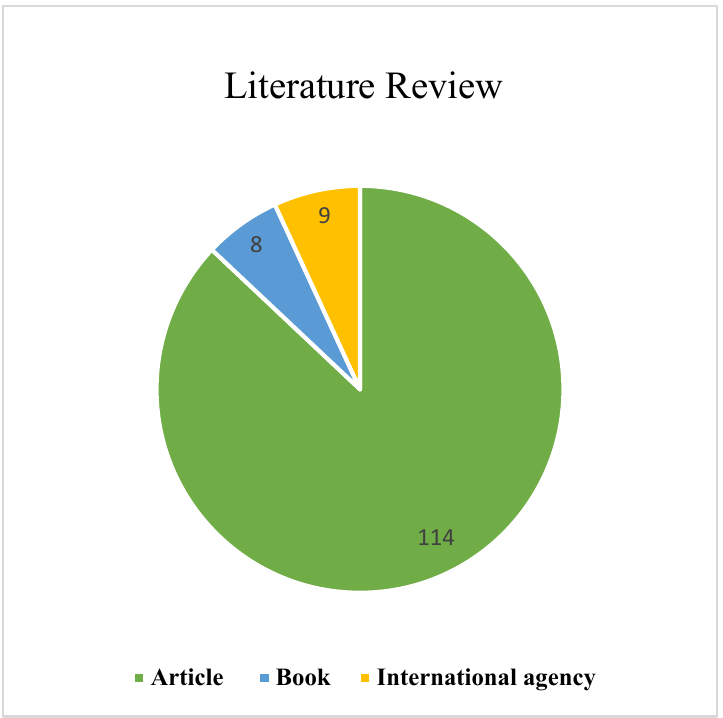
Figure 6. The category of peer-reviewed literature. Table 3. Sources of Indexes.